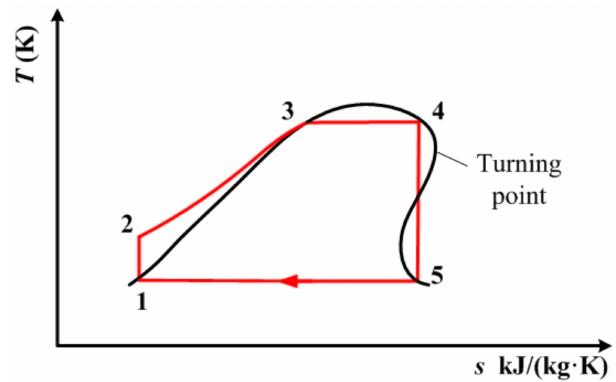
Figure 5. Shape of the saturated vapor curve of R1234yf, resulting in two intersections with the isentropic line.